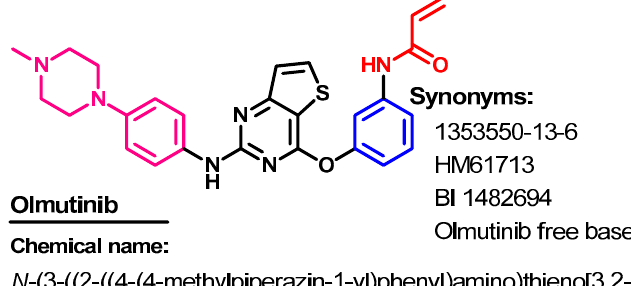
Figure 47. Proposed metabolic pathways of neratinib.